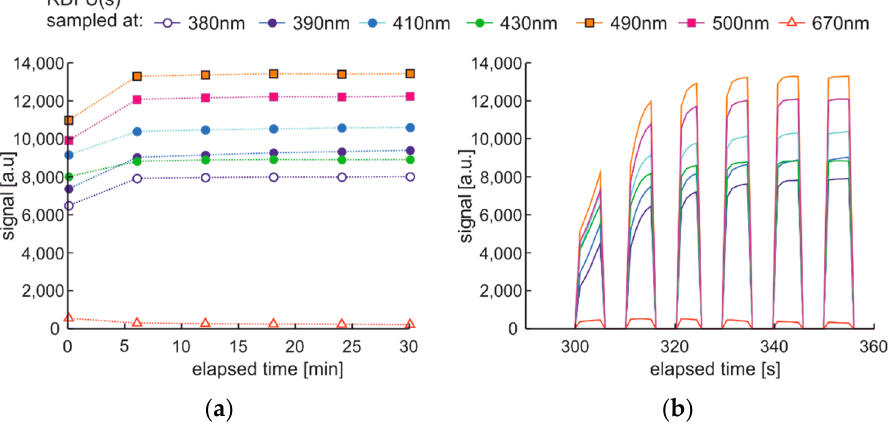
Figure 23. Time series of fluorescence data of regular diesel fuel RDFU(s) in cycle DME:UVoffTon: ( a ) full-time series; ( b ) zoom of the initial pack.